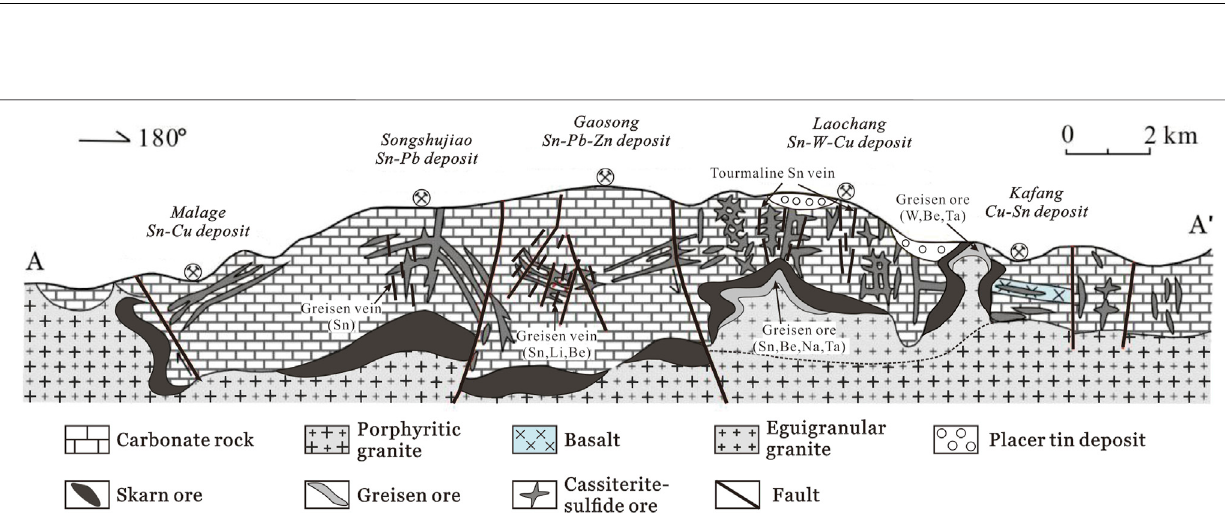
Frontiers in Earth Science |